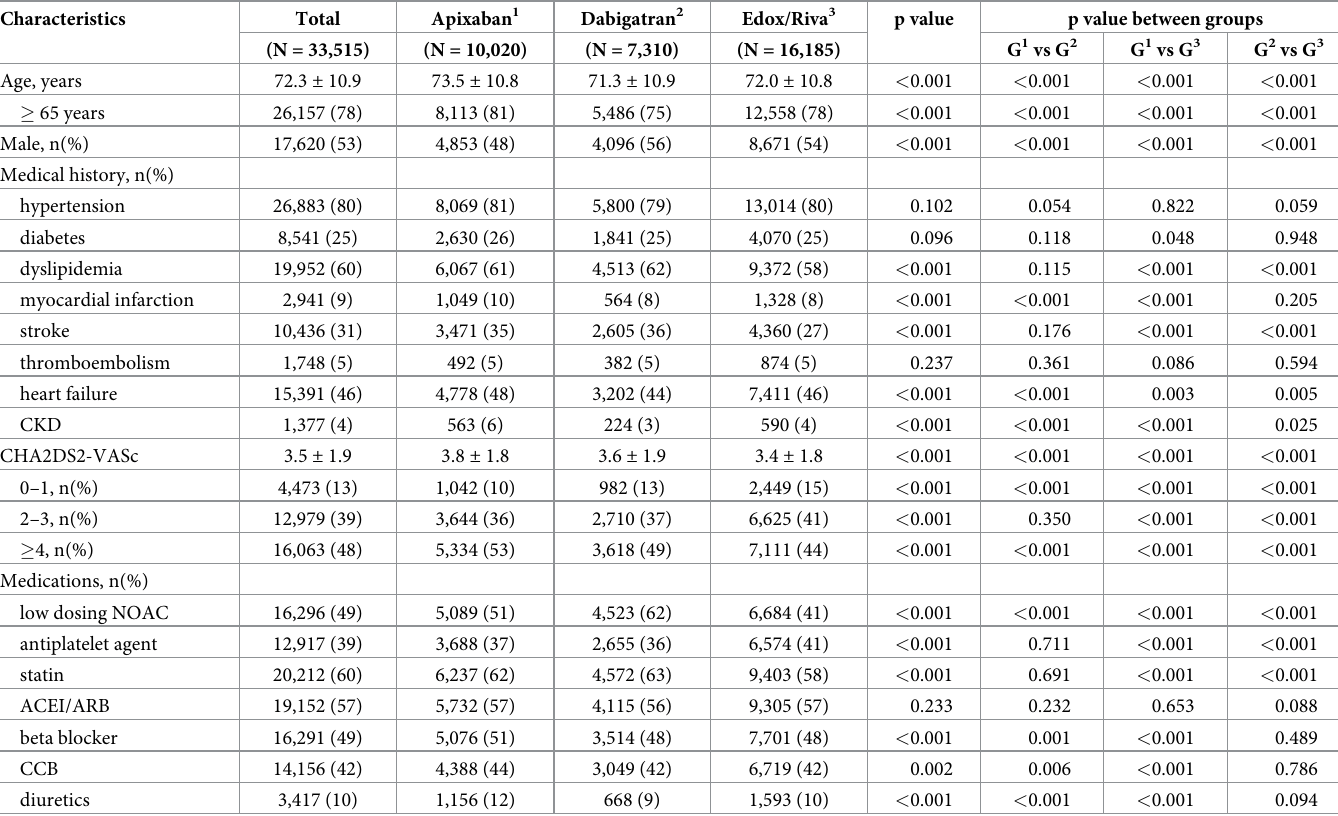
Table 1. Clinical characteristics in NOAC